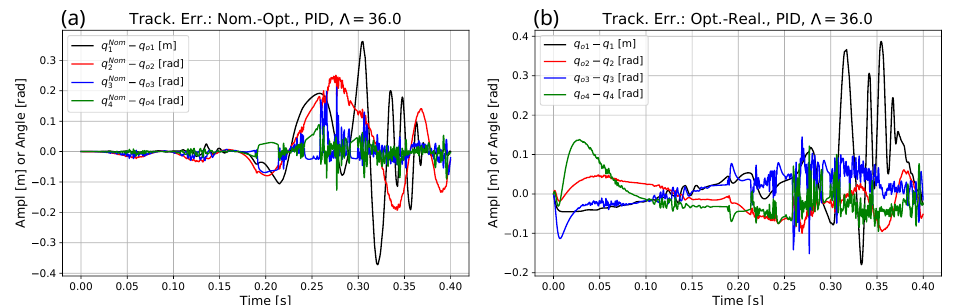
Figure 23. Trajectory tracking with force limitation ∆ u = 495.0 N or N · m for the increased α min = 0.1. ( a ) For q 1 and q 2 . ( b ) For q 3 and q 4 .